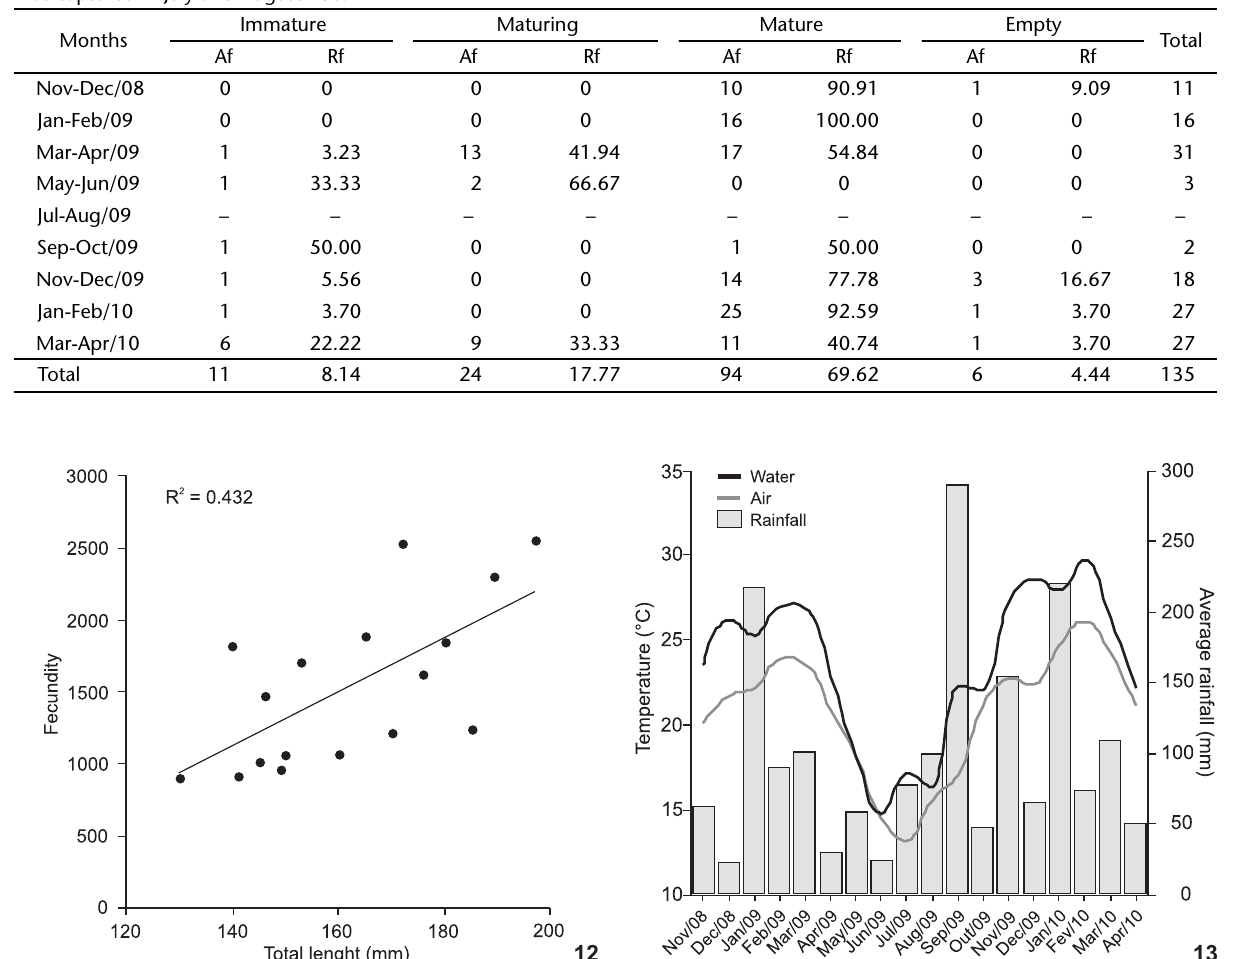
Figures 12-13. (12) Linear regression between fecundity and total length (mm) for 17 mature females of Trachelyopterus lucenai cap- tured in Itapeva, Quadros and Malvas lagoons in the Tramandaí River system, Rio Grande do Sul. (13) Water temperature (°C) per sample collection, and monthly means of air temperature (°C) and rainfall (mm) in the Municipality of Capão da Canoa, Rio Grande do Sul. Source: FEPAGRO, April